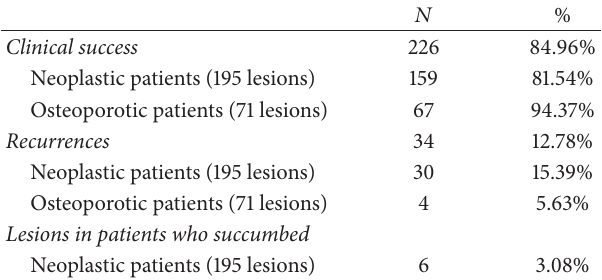
Table 5: Treatment outcomes ( 𝑁 = 266